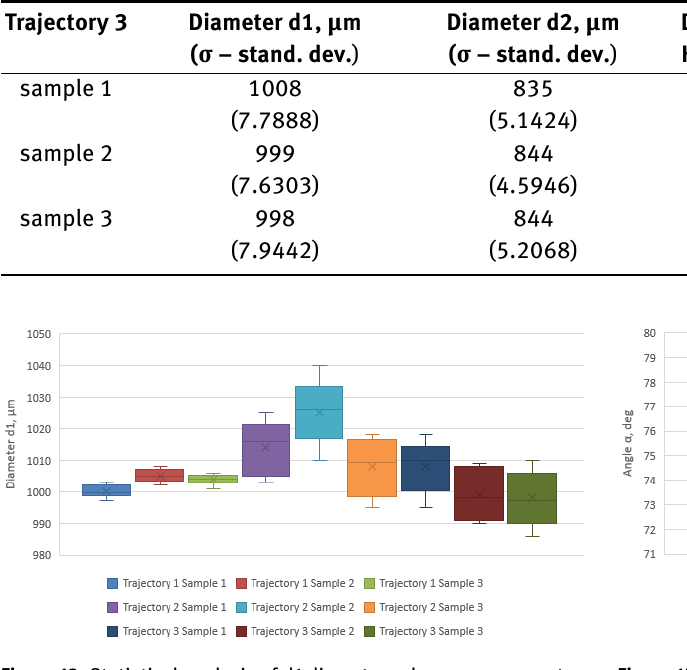
Figure 15: Statistical analysis of angle value measurements for all trajectories.